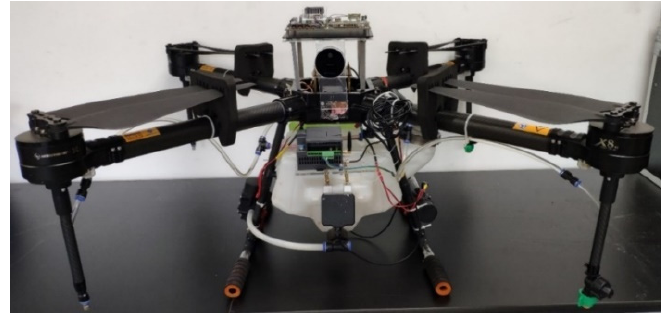
Figure 1. Experimental